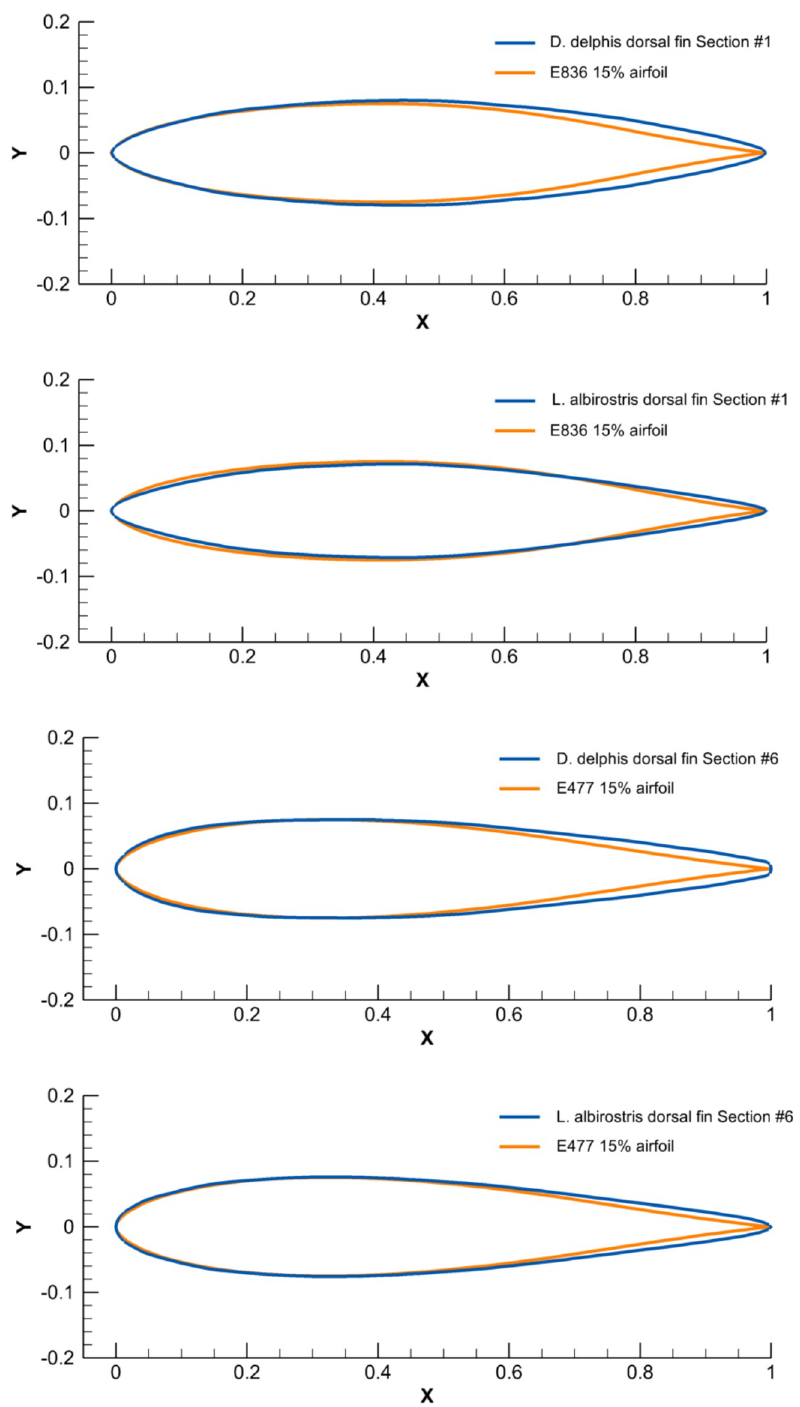
Fig 7. Comparison of the chord-normalized profile coordinates of cross-sections taken at the base and top of the dorsal fin of the selected species with the conventional airfoils.